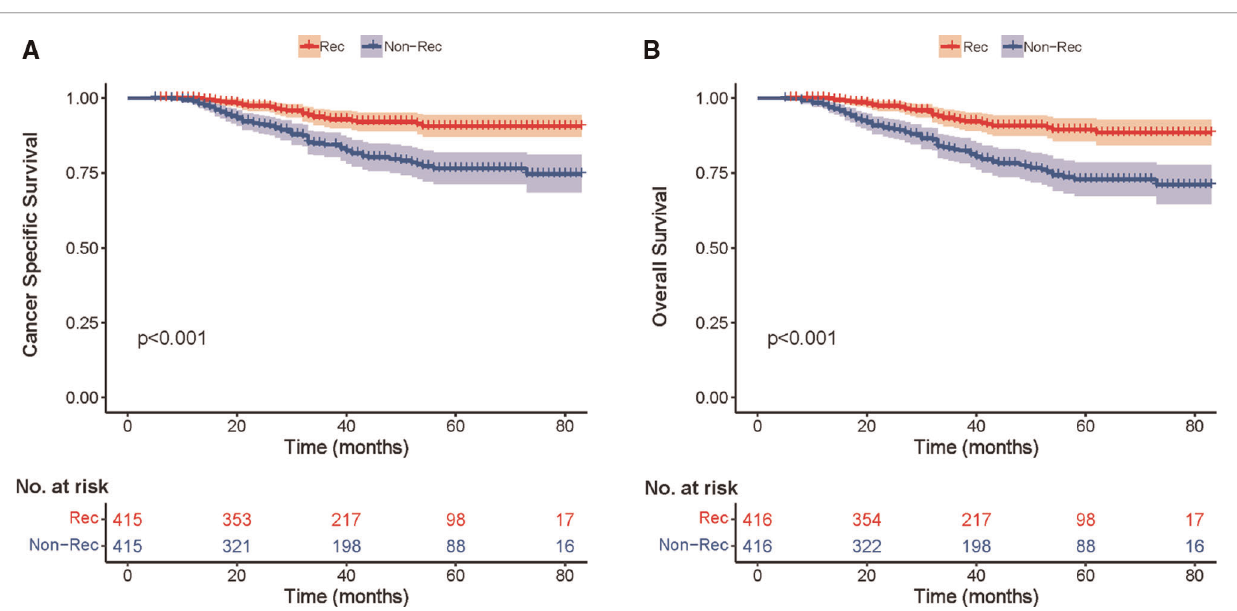
FIGURE 2 | Kaplan – Meier curves comparing breast cancer-speci fi c survival ( A ) and overall survival ( B ) for reconstruction vs. non-reconstruction groups in the exactly matched cohort ( n =832) after propensity score